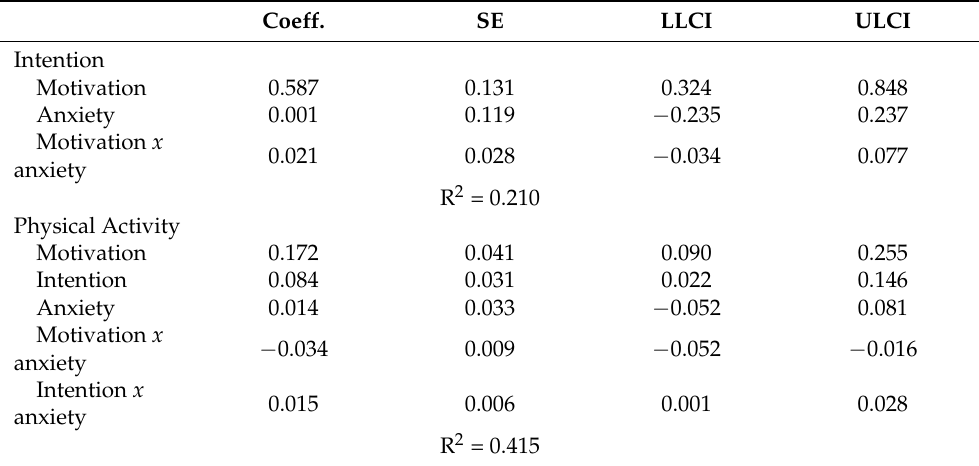
Table 1. Coefficients for the moderated mediation model without past physical activity.